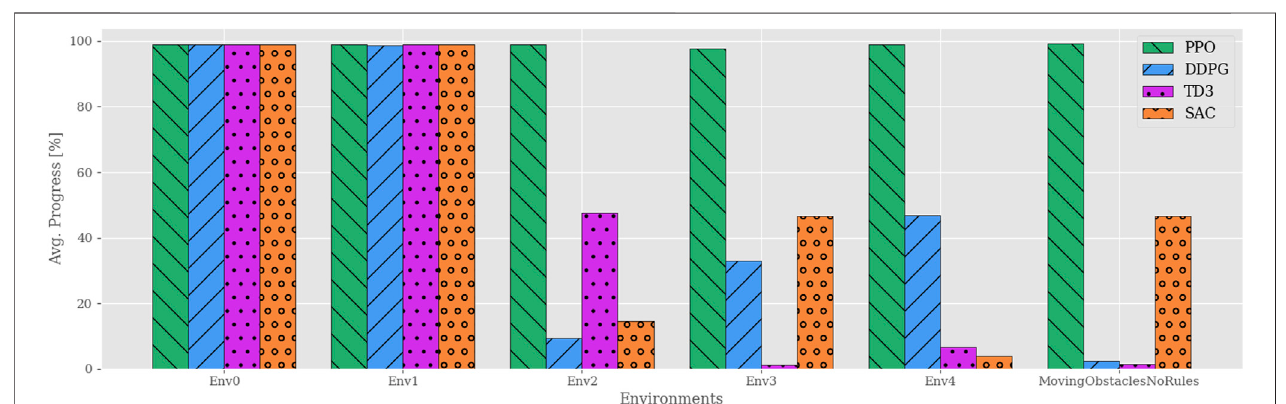
FIGURE 3 | Average progress for all algorithms plotted vs environments of increasing complexity. Each agent is individually trained and tested in their respective environments, e.g., agents trained in Env0 are tested only in Env0. All the algorithms except PPO yield signi fi cantly reduced performance once static obstacles are introduced in Env2. Though neither off-policy algorithm exceeds 50% average progress, their results vary signi fi cantly among the environments.